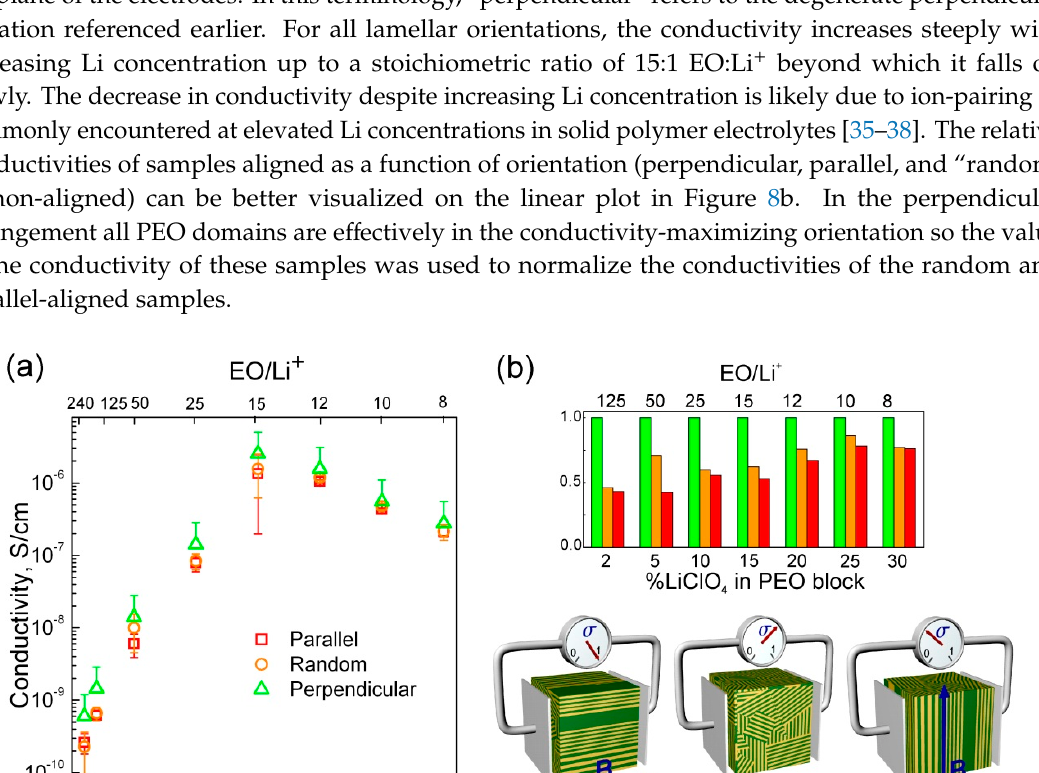
Figure 7. ( a ) Circularly integrated data of PEO-b-PMA/CB samples at different EO:Li + ratios. The samples preserve lamellar morphology at all LiClO 4 doping levels. ( b ) The lamellar period decreases with doping level above 150:1 EO:Li + ratio, while the smectic layer spacing remains unchanged.